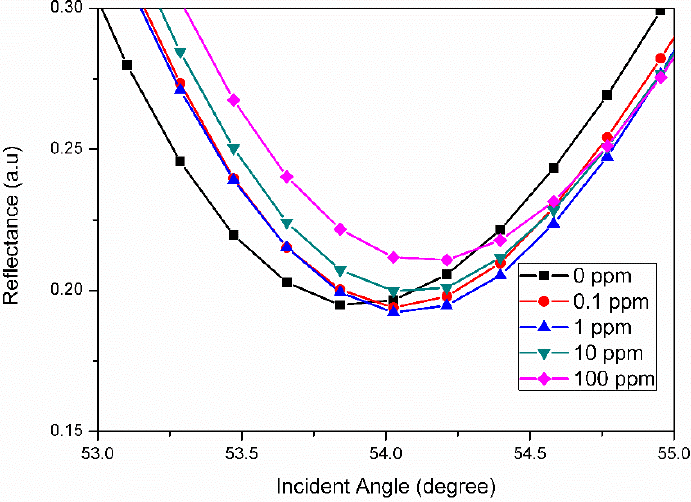
Figure 7. Schematic diagram of an optical biosensor for cobalt detection.